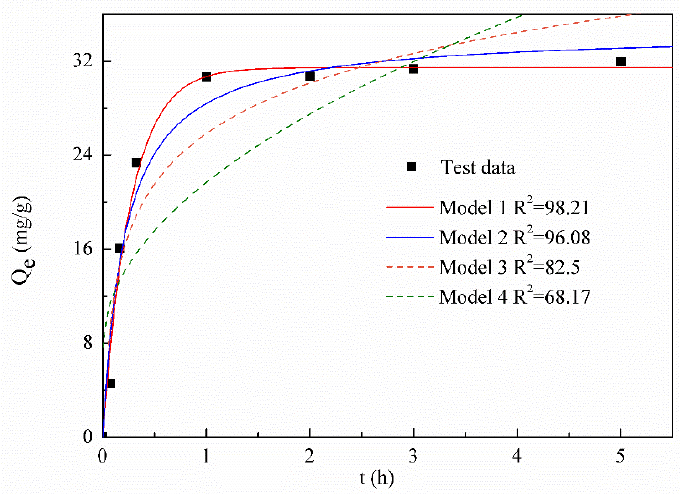
Figure 6. Kinetics curve of calcium ion adsorption on molybdenite.